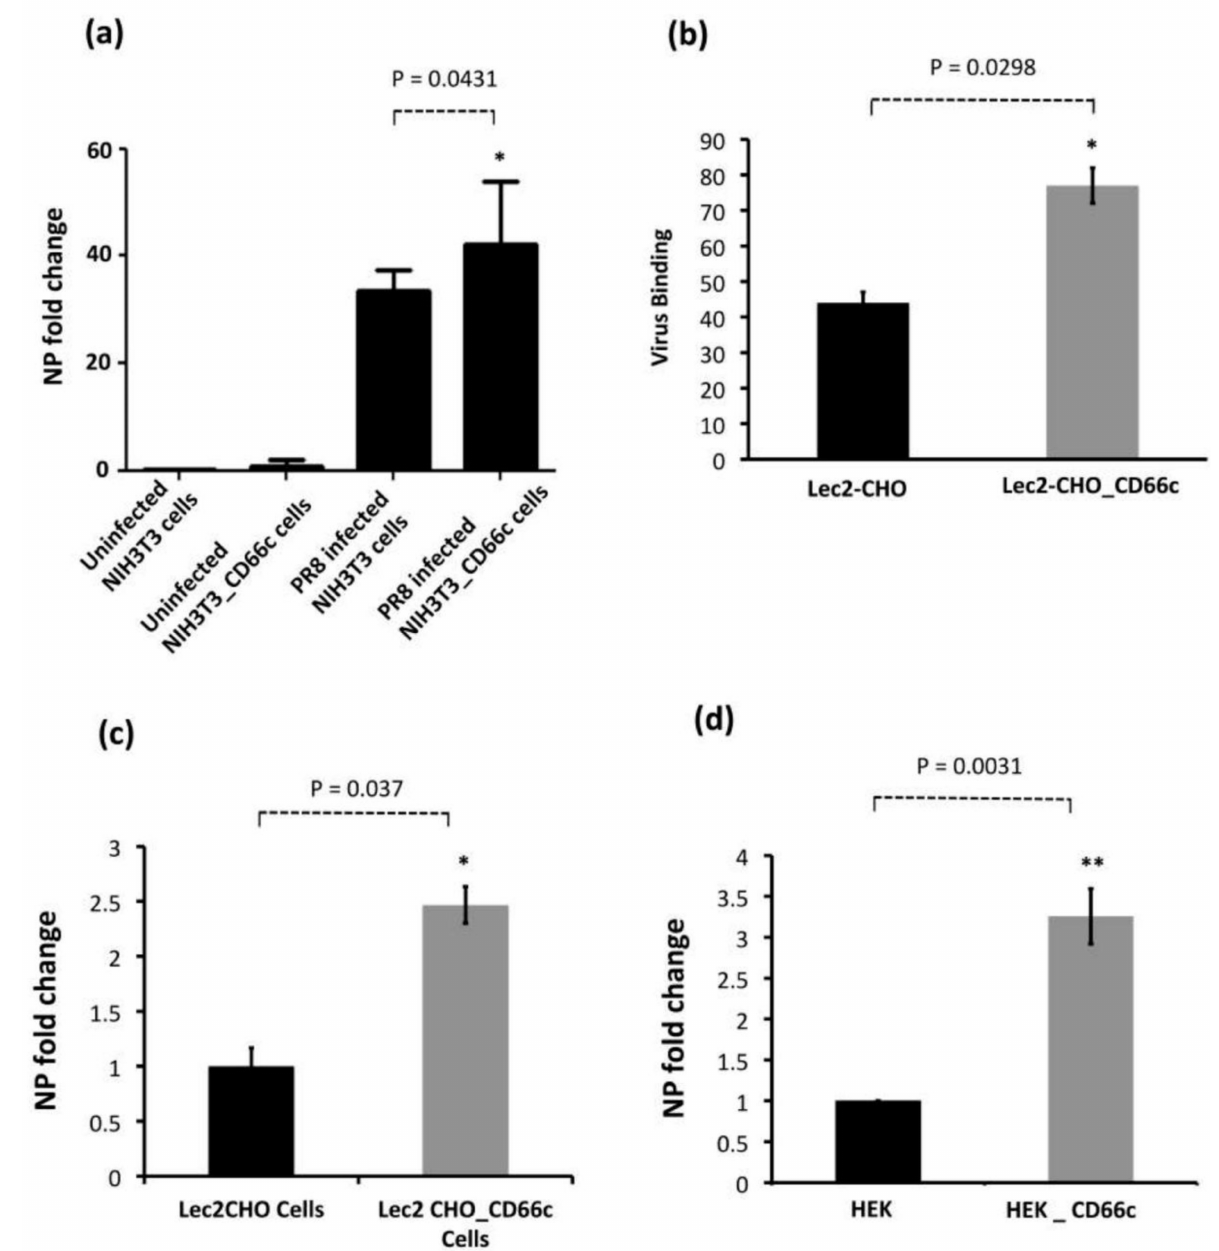
Figure 3. Demonstration of rise in viral uptake in CD66c overexpressing NIH 3T3 and Lec2-CHO cell lines. ( a ): The level of infection as probed by the NP mRNA fold-change. The bar in the right end shows increased influenza infection in CD66c transfected NIH3T3 cell lines. ( b ): Lec2 CHO-CD66c is CD66c overexpressing Lec2 CHO cell lines. The right bar shows greater virus binding on the surface of cells overexpressing CD66c. ( c ): An increased level of viral NP mRNA in Lec2 CHO-CD66c cells (right bar) as compared to Lec2 CHO cells (left bar) suggesting increased virus entry. ( d ): Levels of mRNA corresponding to lower infection level in HEK cells (left bar) and an increase in infection in CD66c overexpressing HEK cells (right bar). Statistical significance was assessed by student’s t -test, (*) for p ≤ 0.05 and (**) for p ≤